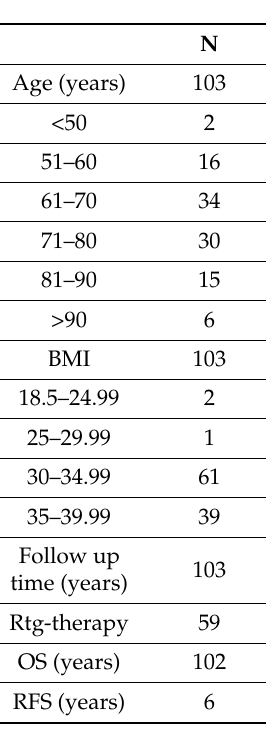
Amplicon-based gene panel protocol: Amplification of the hotspot regions of 50 oncogenes and tumour suppressor genes was carried out using AmpliSeq™Library PLUS for Illumina ® assay Kit (San Diego, CA, USA) according to the